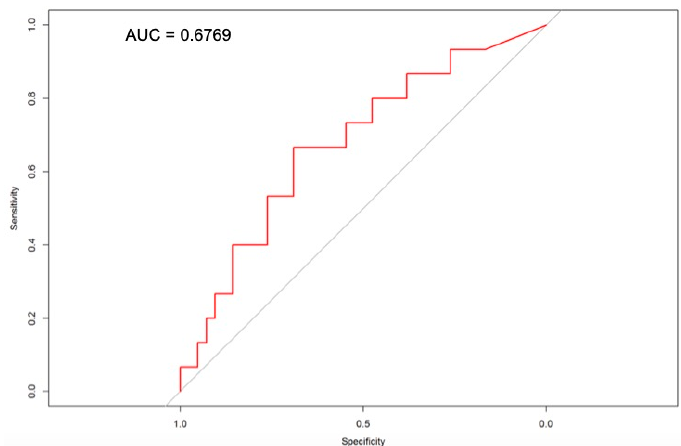
Figure 2. Receiver operating curve for sST2 concentration assessed on admission day in relation to the concentration during the postprocedural period with complications. AUC—area under the curve.